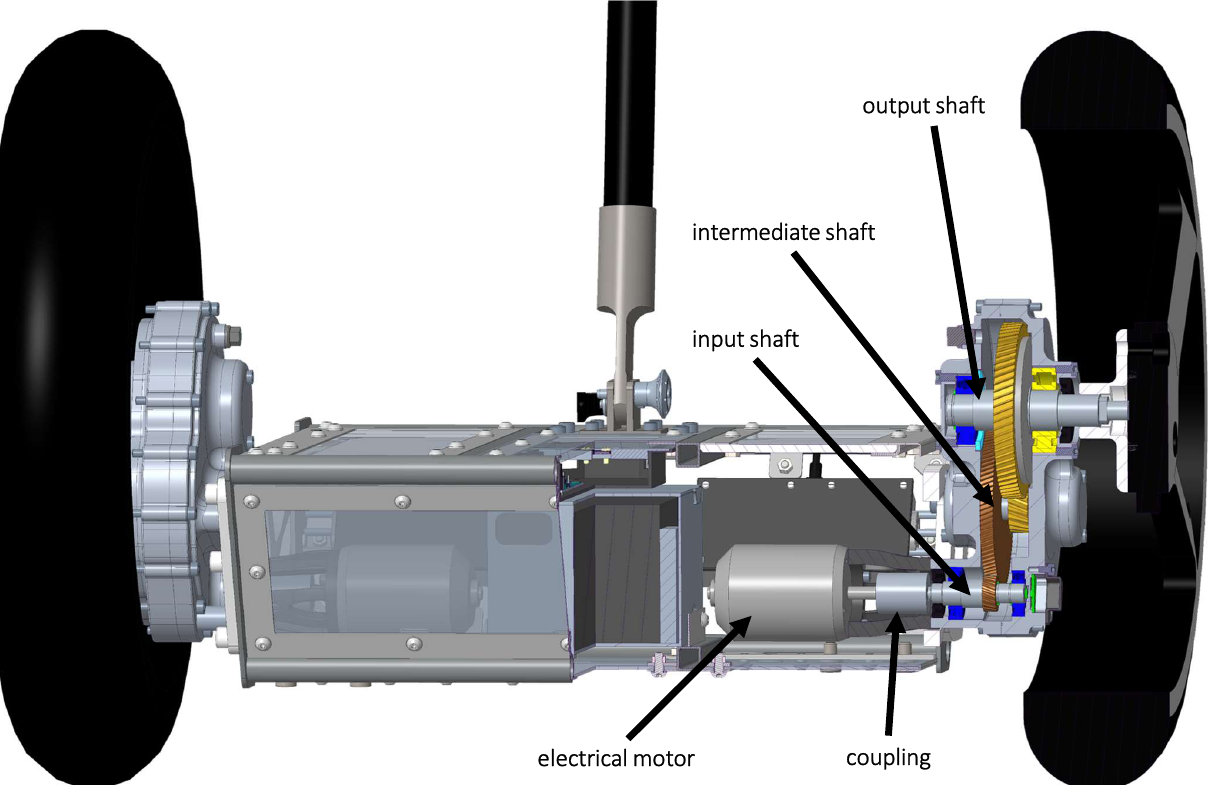
Figure 2. Scooter drive